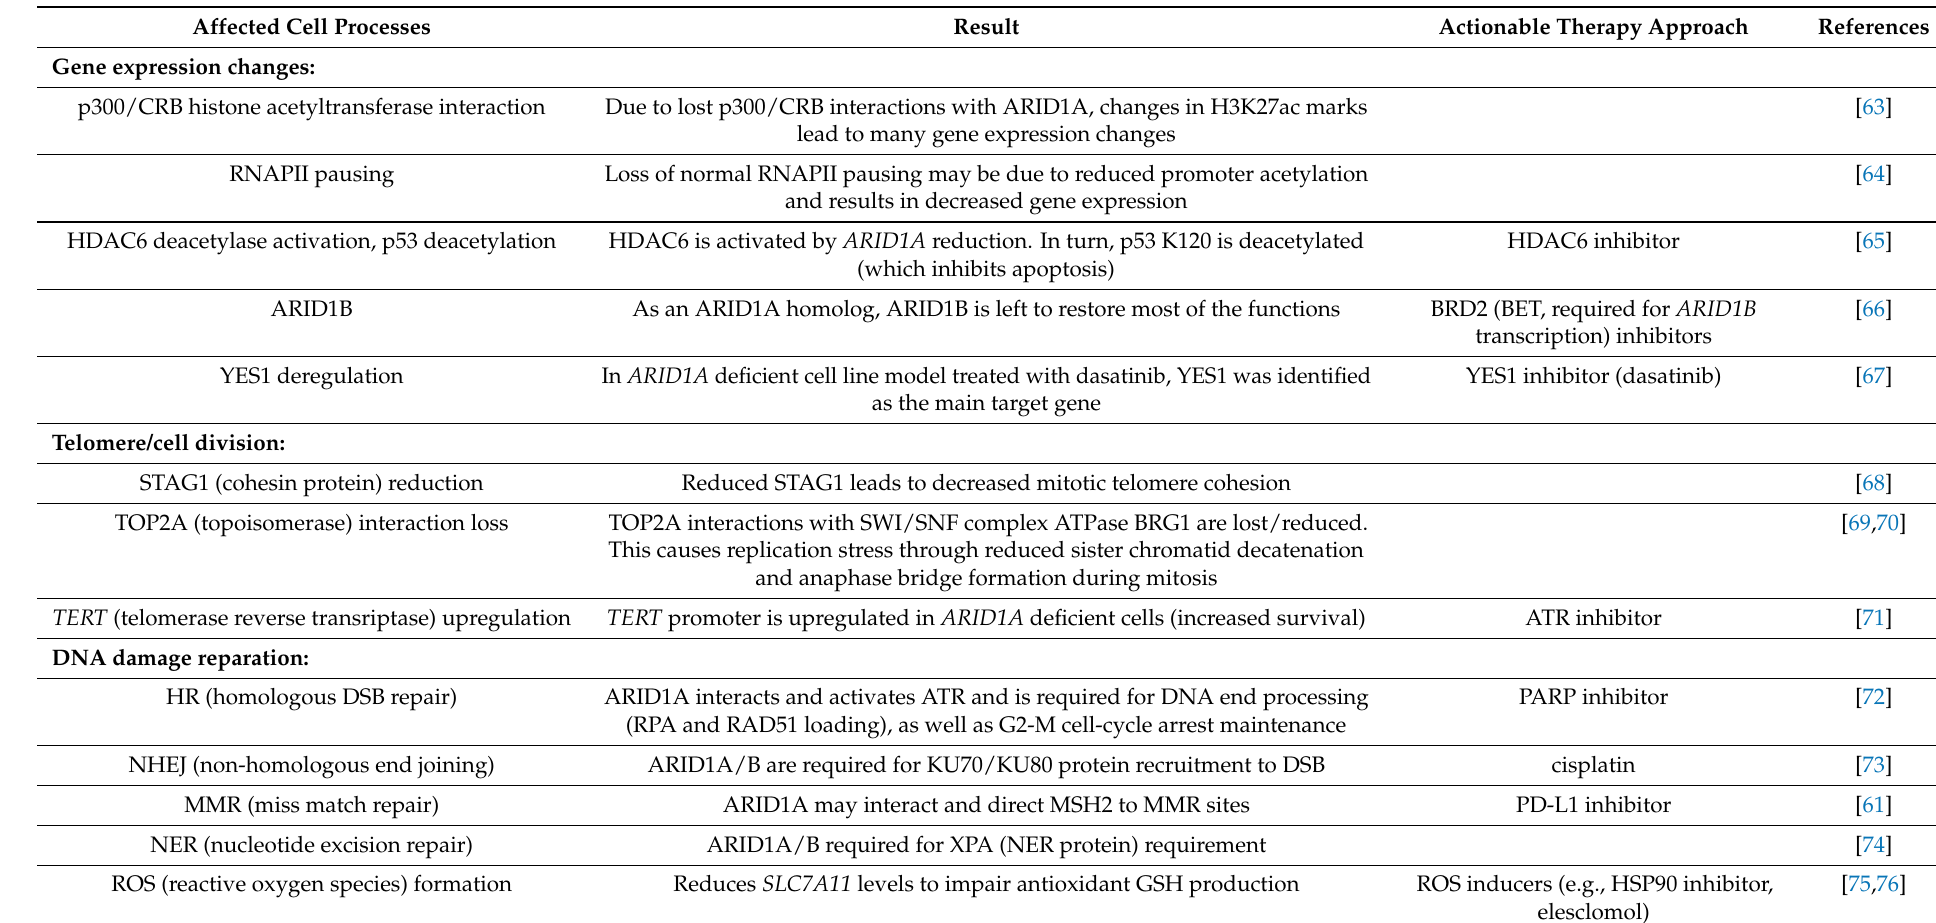
Table 3. Effects of ARID1A loss of function mutations and opportunities for cancer